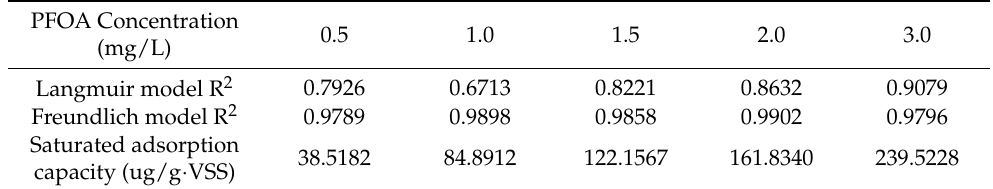
Figure 3. Change of PFOA concentration in supernatant of each reactor ( I ) and thermodynamic model fitting results of sludge adsorption PFOA amount within 24 h ( II ) (Figure 3a–e initial concentrations of PFOA were 0.5, 1.0, 1.5, 2.0, and 3.0 mg/L). Table 1. After fitting Langmuir and Freundlich adsorption models, the R 2 of PFOA adsorbed by sludge and the saturated adsorption capacity of sludge to PFOA.